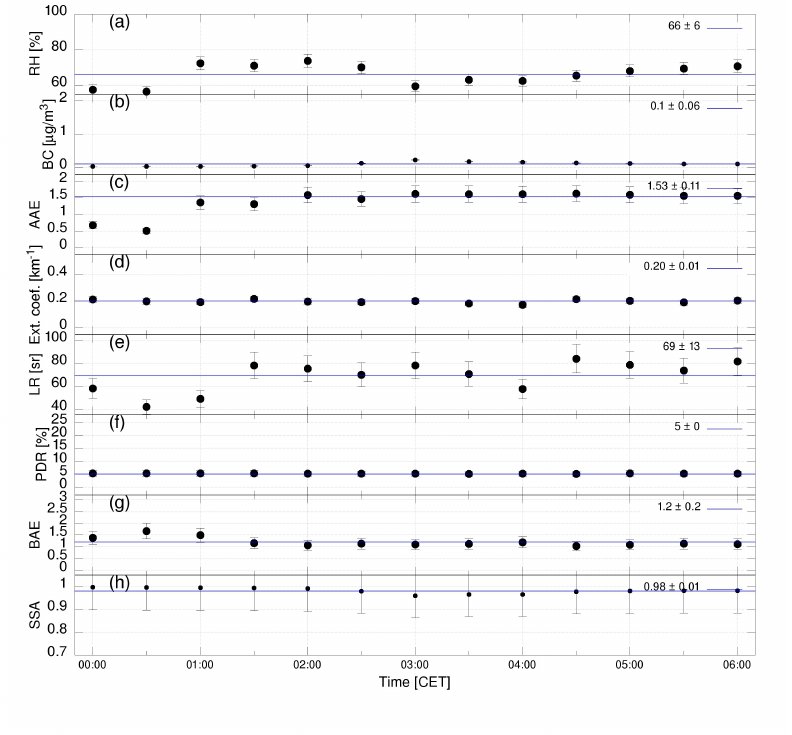
Figure 14. Temporal variation of the observed aerosol observables on 22 December 2017 between 00:00 and 06:00 CET. ( a ) RH, ( b ) BC concentration and ( c ) AAE between 470 and 950nm were obtained at Otlica site, and ( d ) extinction coefficient, ( e ) LR, ( f ) PDR at 355nm and ( g ) BAE between 355 and 1064nm were obtained from lidar measurements at the equivalent height with Ot site, while the SSA at 370nm ( h ) was calculated combining lidar and aethalometer measurements. All data was re-sampled over 30min. Error bars indicate the uncertainties and horizontal lines the mean value of corresponding